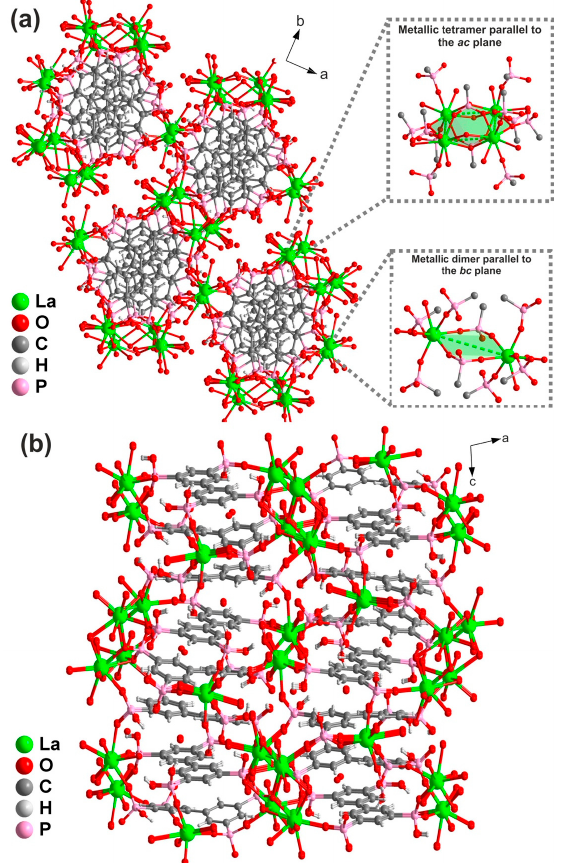
Figure 5. Crystal packing of [La 4 (H 5 btp)(H 4 btp)(H 3 btp)(H 2 O) 8 ] ∙ 3H 2 O ( 2La ) viewed in perspective along the ( a ) [001] and ( b ) [010] directions of the unit cell. The representations also emphasize, simultaneously, not only the presence of a metallic dimer formed by two metal centers and the phosphonic acid groups, responsible for the connection between the “1D” cylinders along the [100] direction, but also the presence of a metallic tetramer which connects the same cylinders along the [010] direction.